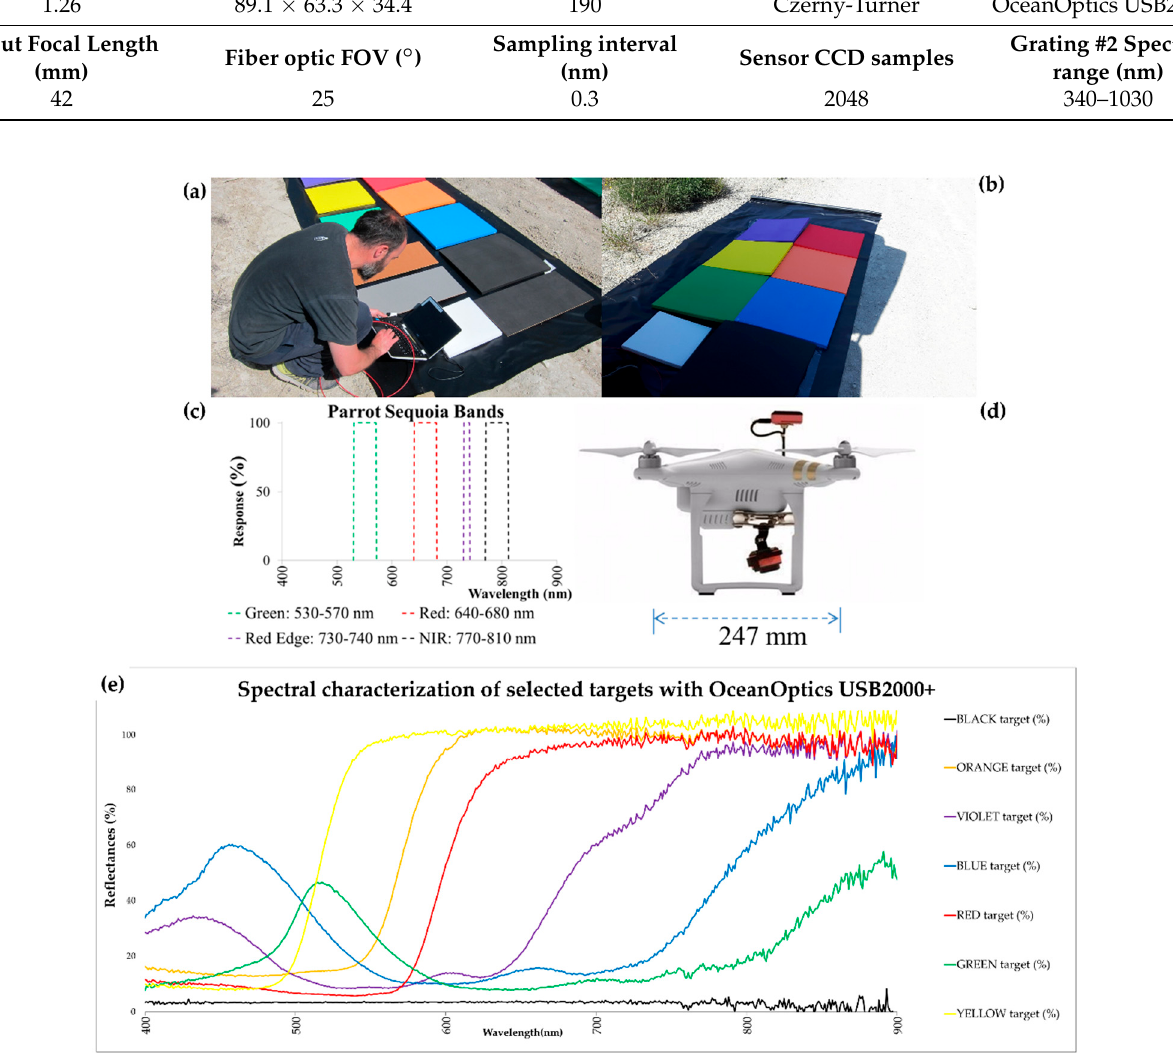
Figure 3. ( a ) Field spectroradiometry measurements. ( b ) Twin set of targets located in diffuse illumination conditions. ( c ) UAV sensor Parrot Sequoia spectral bandwidth. ( d ) UAV vehicle configuration used for the applied scenario in a forested area. ( e ) Spectral signatures of the EVA panels used to obtain the empirical line correction between shadowed and non-shadowed areas. Table 3. Parrot Sequoia camera main features.